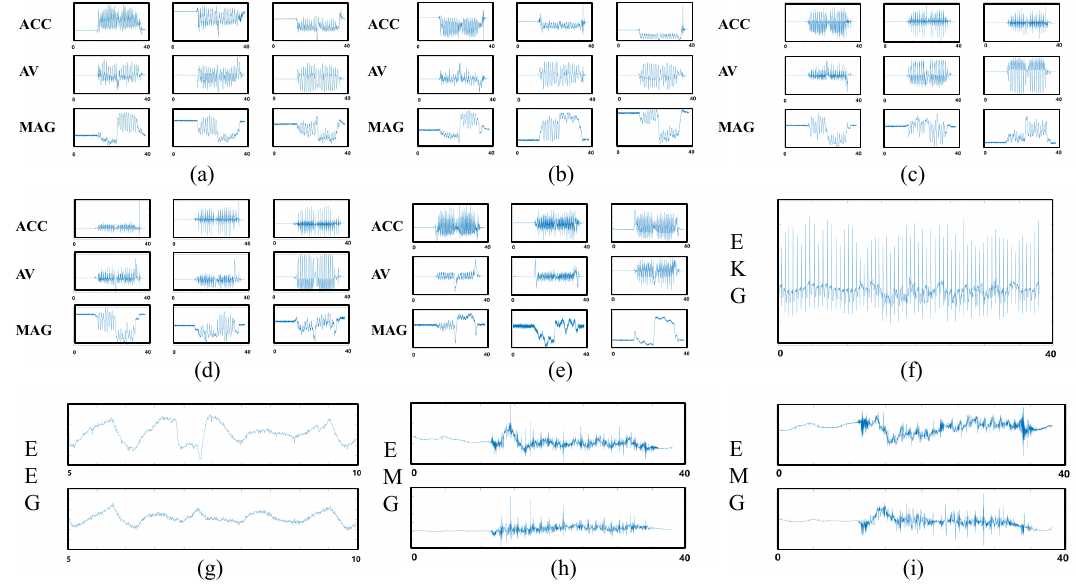
Figure 7. Example of signals measured by the sensors in this system. ( a ) Left wrist motion sensor. ( b ) Right wrist motion sensor. ( c ) Left ankle motion sensor ( d ) Right ankle motion sensor. ( e ) Trunk motion sensor. ( f ) Electrophysiology sensor 2-lead ECG. ( g ) Electrophysiology sensor bipolar input on C2, C4, C1, and C3 positions on the 10/20 EEG template. ( h ) Electrophysiology sensor bipolar EMG input from the left leg. ( i ) Electrophysiology sensor bipolar EMG input from the right leg.